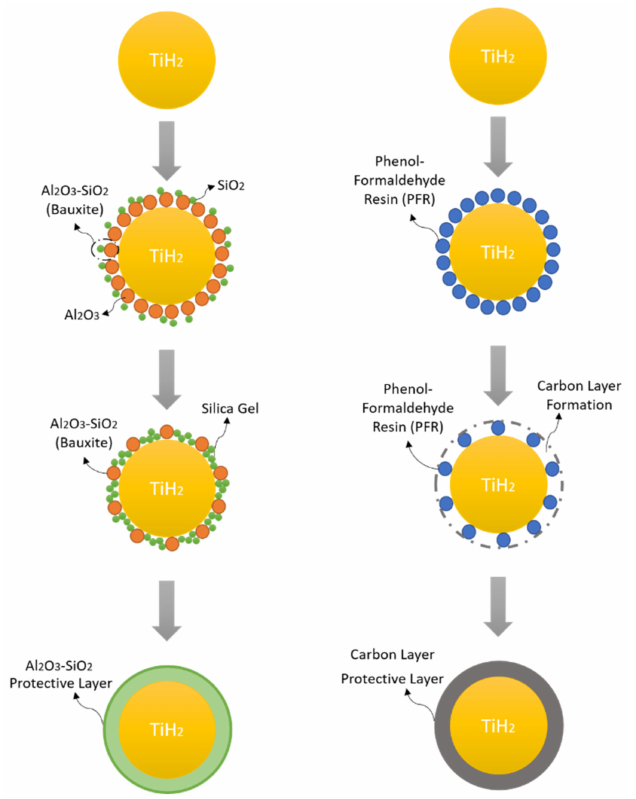
Figure 10. Mechanisms for delaying the release of H 2 gas in TiH 2 -modified by bauxite and